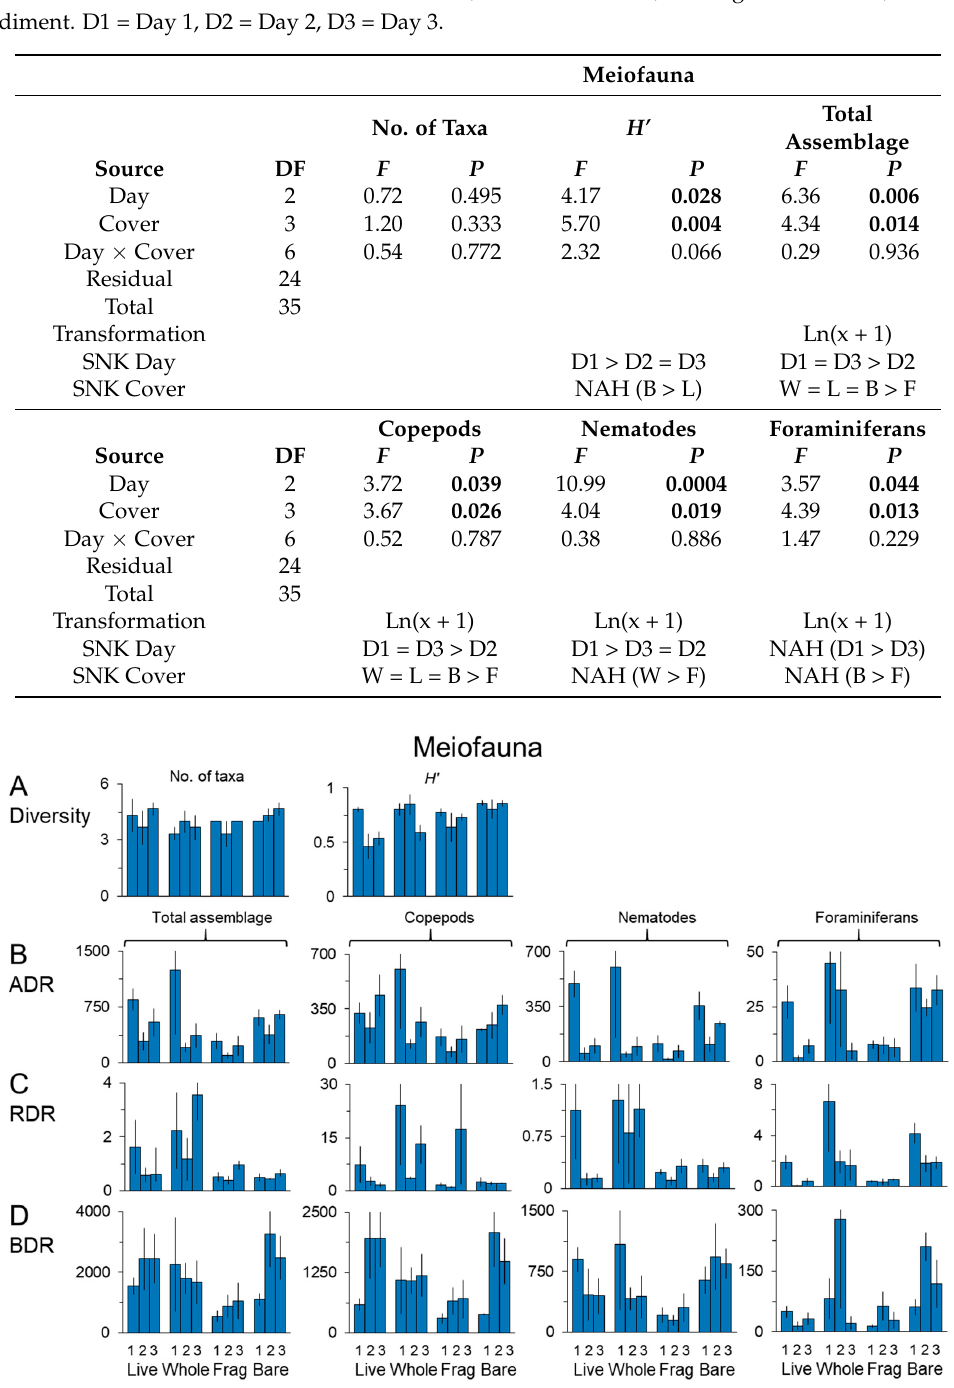
Figure 4. ( A ) Meiofauna values for number of taxa and H’ in traps. ( B ) Meiofauna absolute dispersal rates (ADR). ( C ) Meiofauna relative dispersal rates (RDR). ( D ) Meiofauna bulk dispersal rates (BDR). Values are mean ± 1 SE. Live = Live mussels, Whole = Whole shells, Frag = Fragmented shells, Bare = Bare sediment. 1 = Day 1, 2 = Day 2, 3 = Day 3.